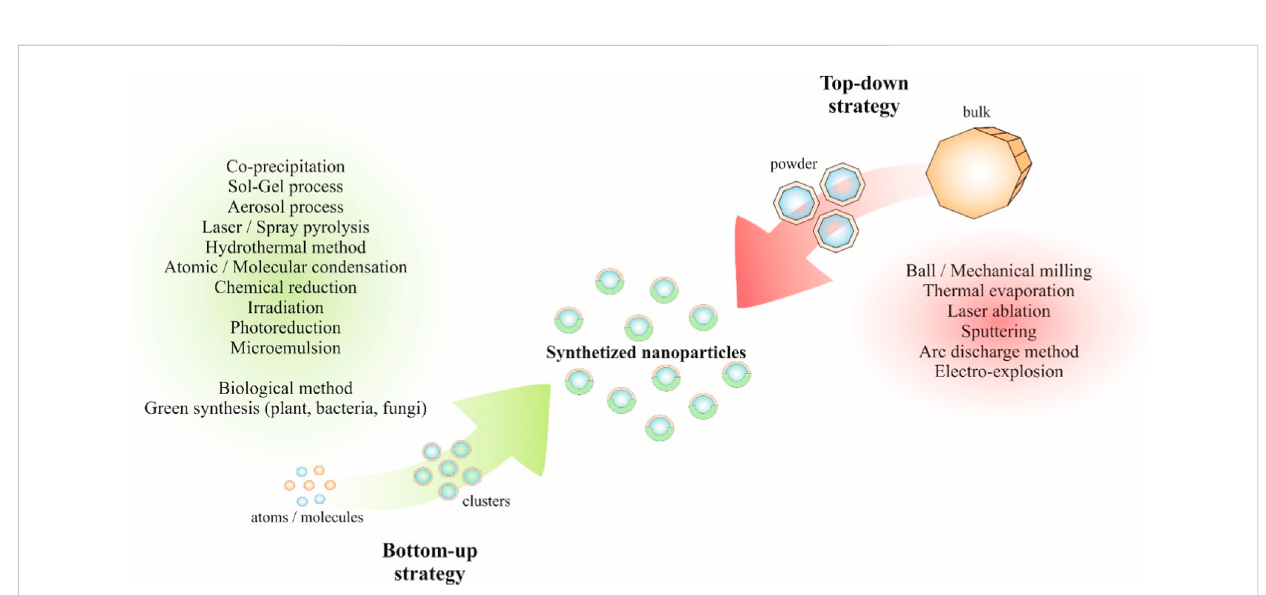
Synthesis of NPs by bottom-up or top-down